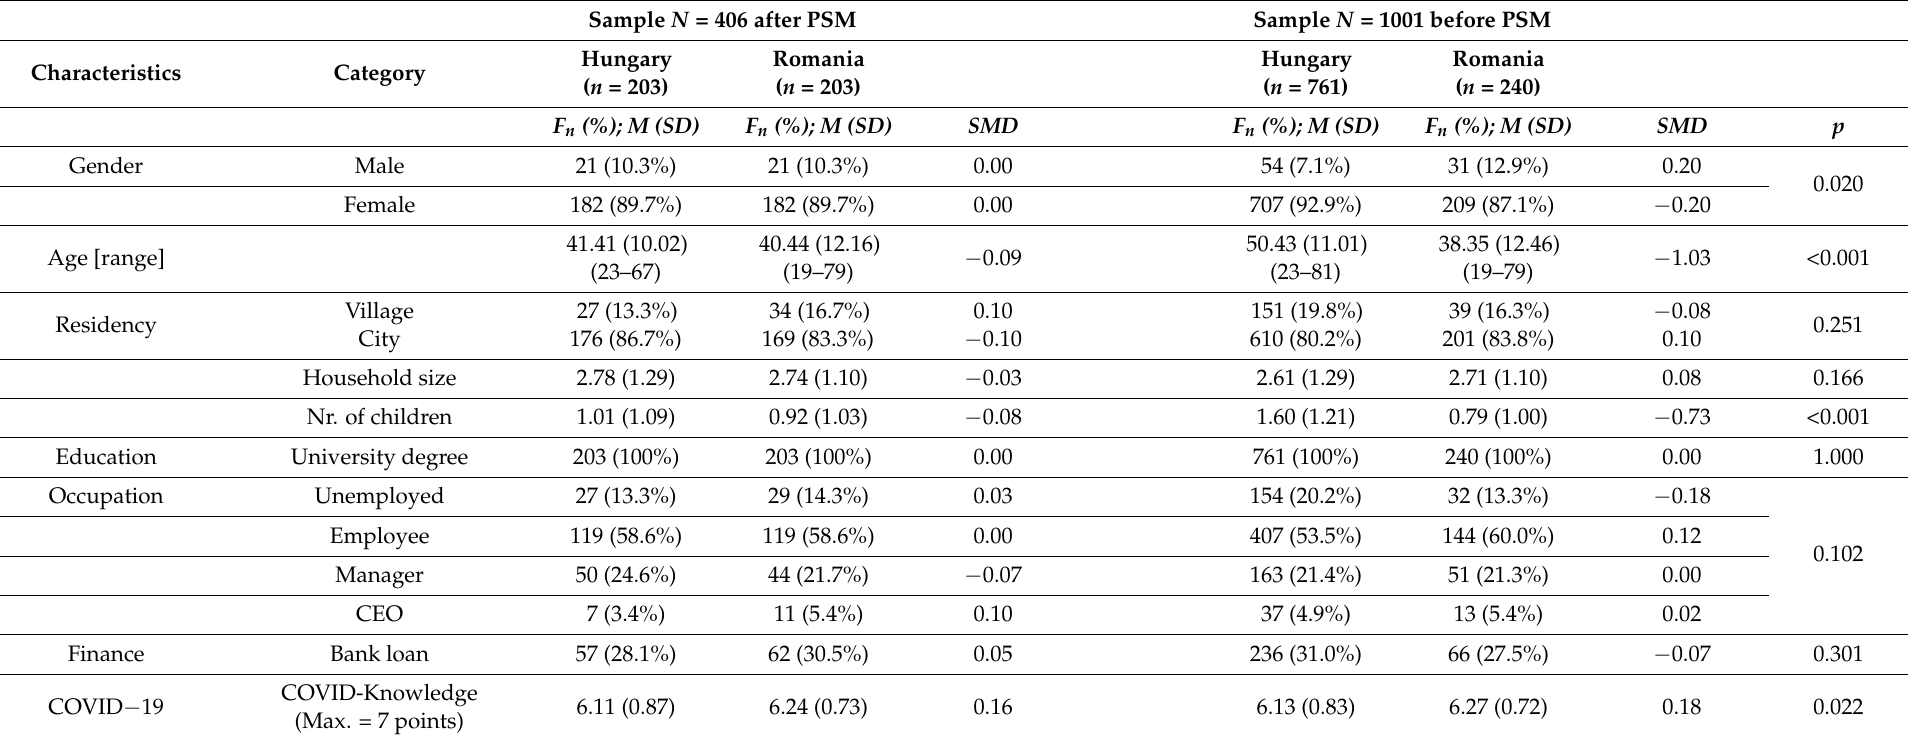
Table 1. Sample characteristics, baseline measures and standardized mean differences before (right; N = 1001) and after (left; N = 406) propensity score matching, and treatment effects on COVID-19 dependent variables